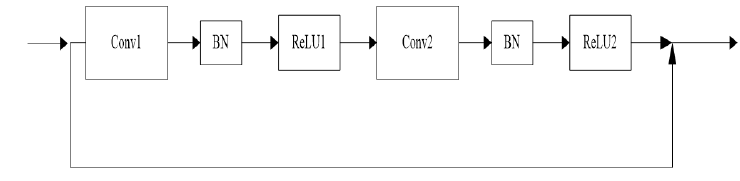
Fig. 3 Residual block structure A.